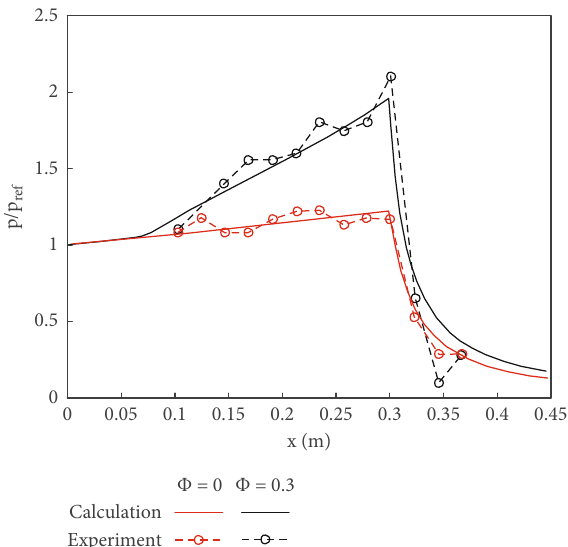
Figure 8: Comparison of computational results and experimental data of the HyShot II scramjet